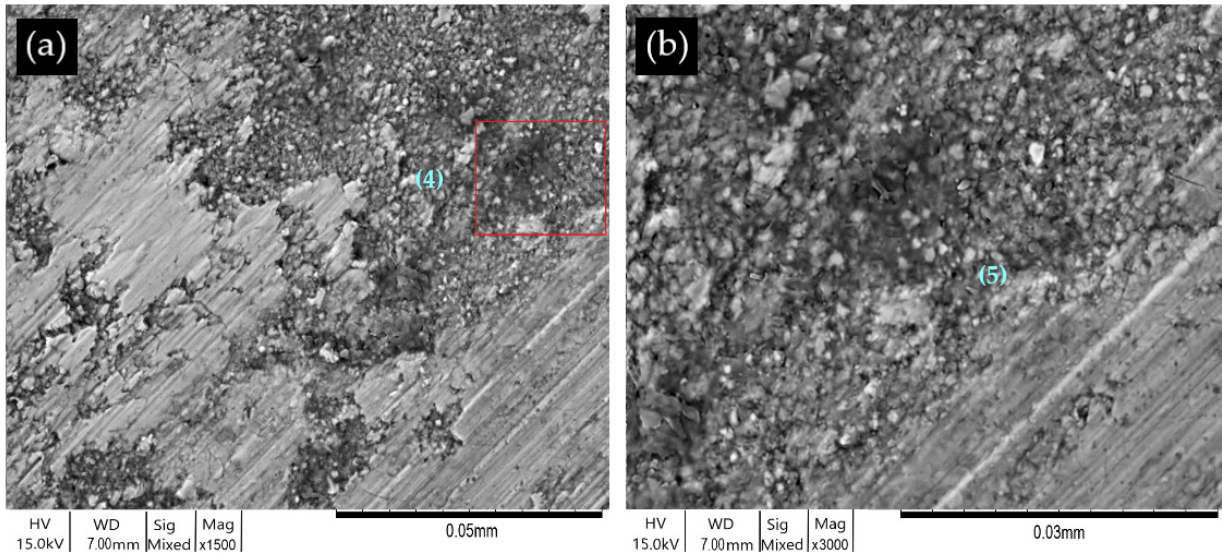
Figure 12. SEM images of Coating B after pin-on-disc Test 2b: ( a ) ×50 magnification, ( b ) ×800 magnification.